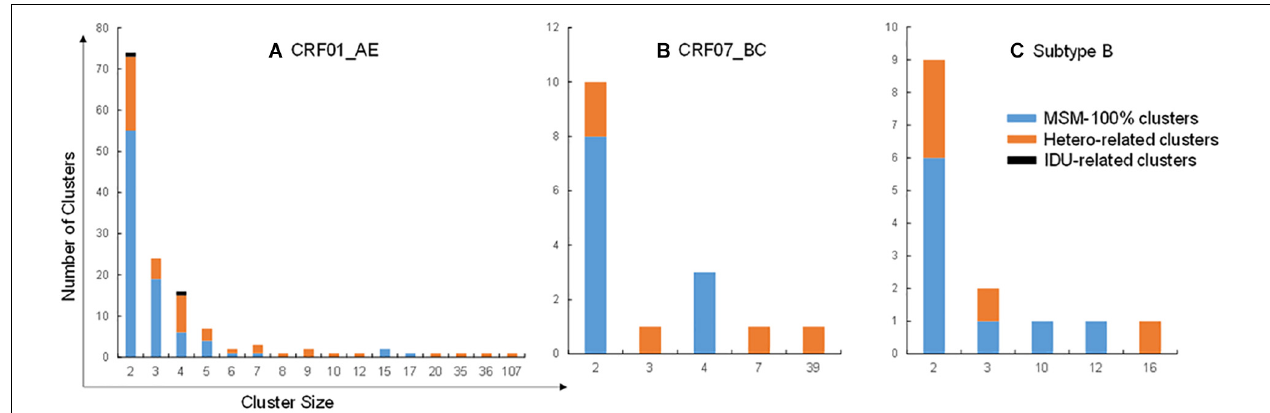
FIGURE 1 | Distribution of risk group clusters. (A–C) Risk group clusters in transmission networks of CRF01_AE (A) , CRF07_BC (B) , and subtype B (C) . Blue, orange, and black columns represents clusters containing 100% MSM and hetero- and IDU-related clusters, respectively.